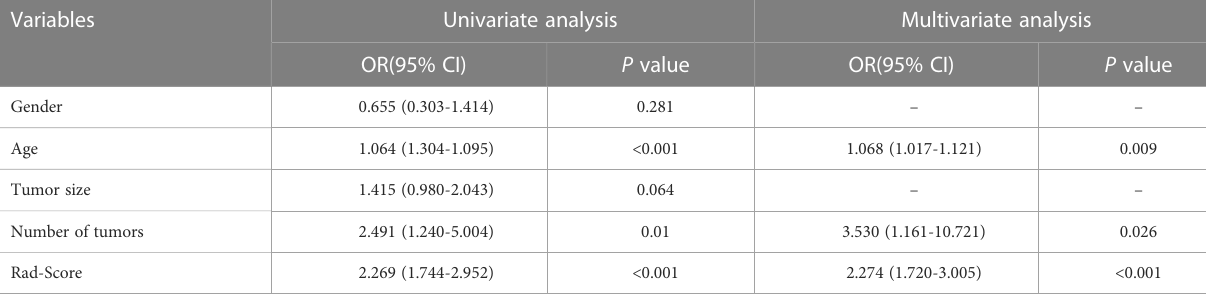
TABLE 2 Risk factors for high grade in non-muscle-invasive bladder cancer. Variables Univariate analysis